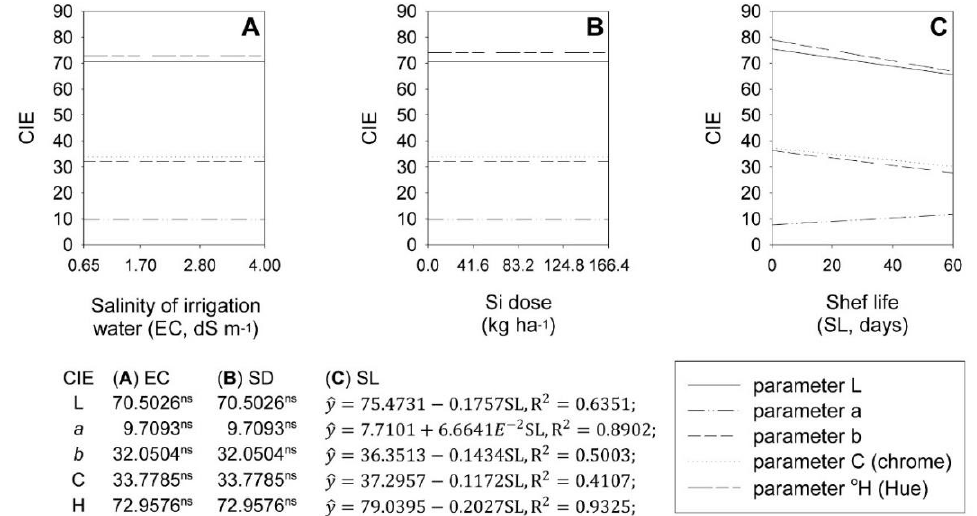
Figure 2. Effect of increasing salinity (EC) ( A ), silicon doses (SD) ( B ), and shelf life (SL) ( C ) on the coloration of ‘Rio das Antas’ onion bulbs, parameterized according to CIE standard L*, a*, b*, C*, and °H.